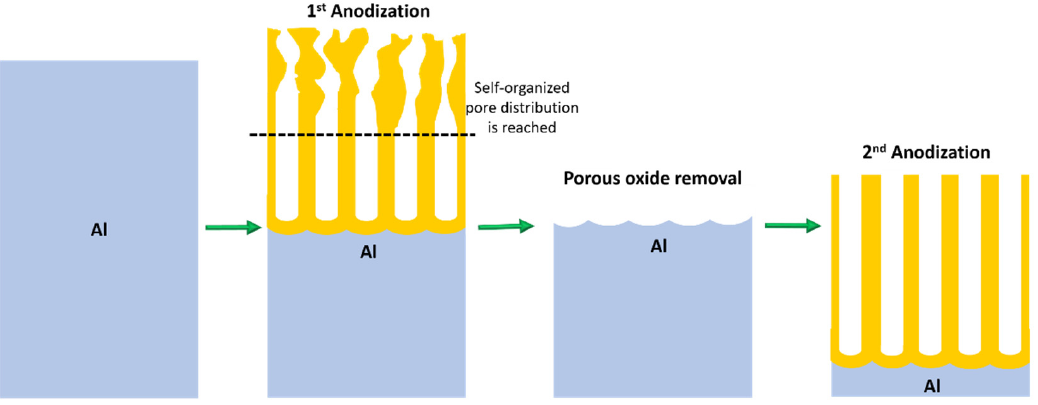
Figure 4. Steps involved in the two-step anodization process.